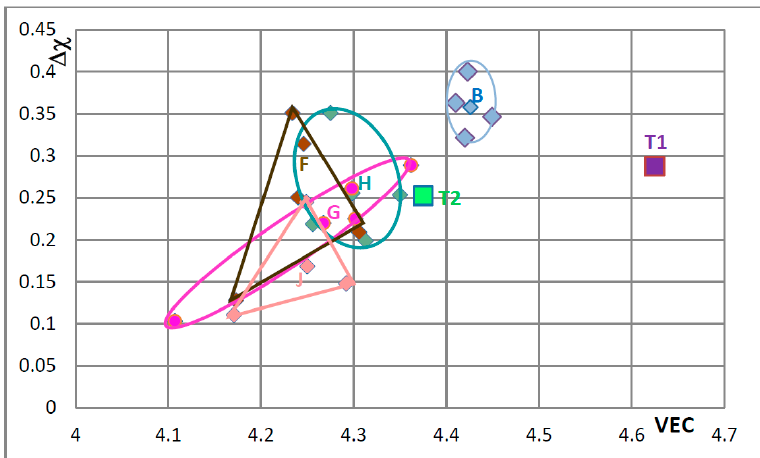
Figure 10. Δχ versus VEC map of unalloyed and alloyed Nb 5 Si 3 that shows the effect of the substitution of Nb by a transition metal or refractory metal addition, where T1 = Nb 5 Si 3 , T2 = Nb 5 (Si,B) 3 , area B = (Nb,Ti,Cr) 5 (Si,Al) 3 , area F = (Nb,Ti,Cr,Hf) 5 (Si,Al,B) 3 , area G = (Nb,Ti,Cr,Mo) 5 (Si,Al,B) 3 , area H = (Nb,Ti,Cr,Ta) 5 (Si,Al,B) 3 and area J = (Nb,Ti,Cr) 5 (Si,Al,B,Sn) 3 . The data is from KZ5 type alloys with nominal compositions Nb-24Ti-18Si-5Al-5Cr + 5X, where X = Hf, Mo, Ta, Sn. Average positions in areas B and F to J are indicated by data point closest to letter (see text).